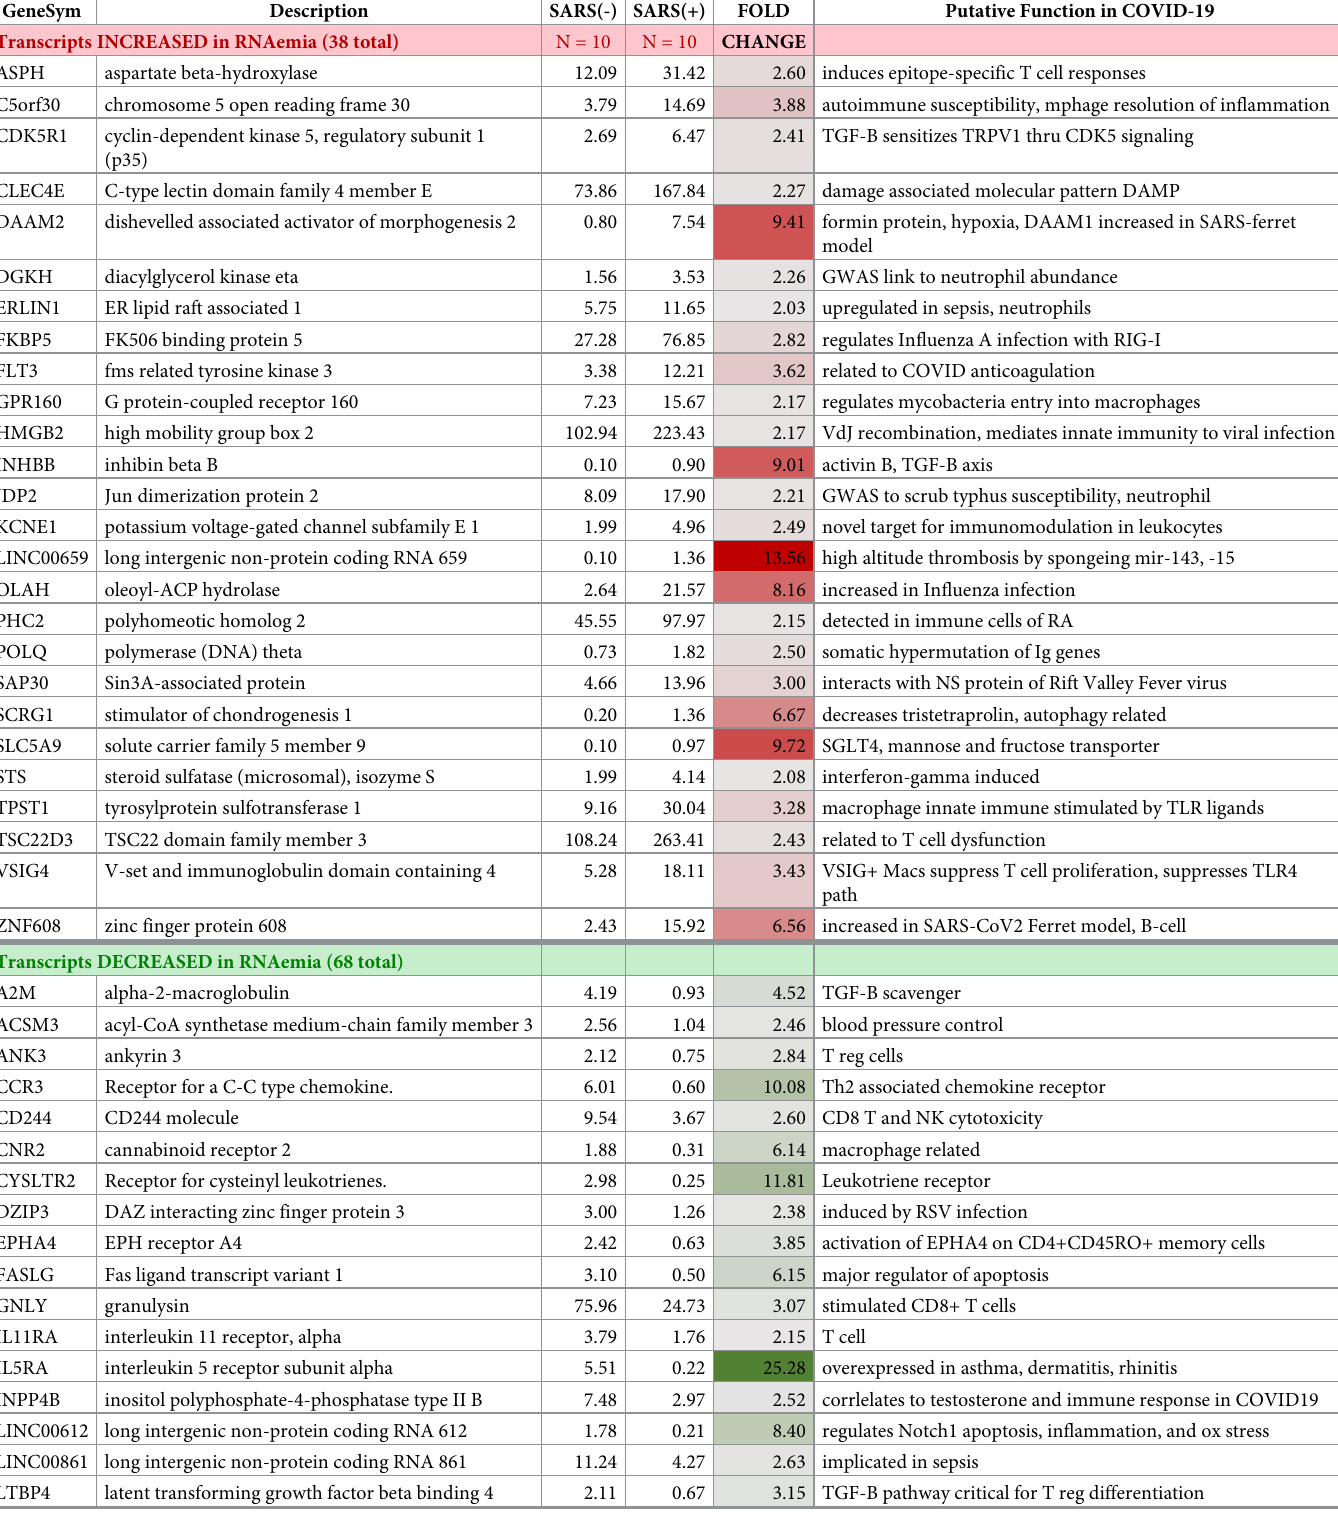
Table 2. Selected transcripts differentially expressed in SARS-COV2 seropositive vs seronegative cases.